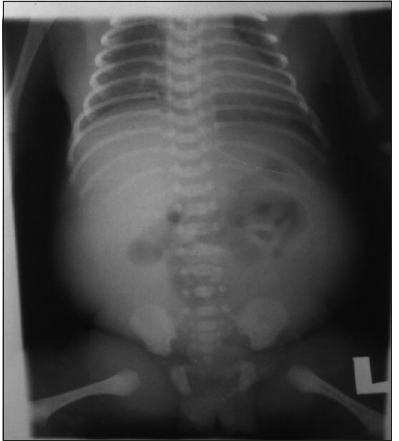
Figure 1: Plain abdominal radiograph showing dilated proximal small